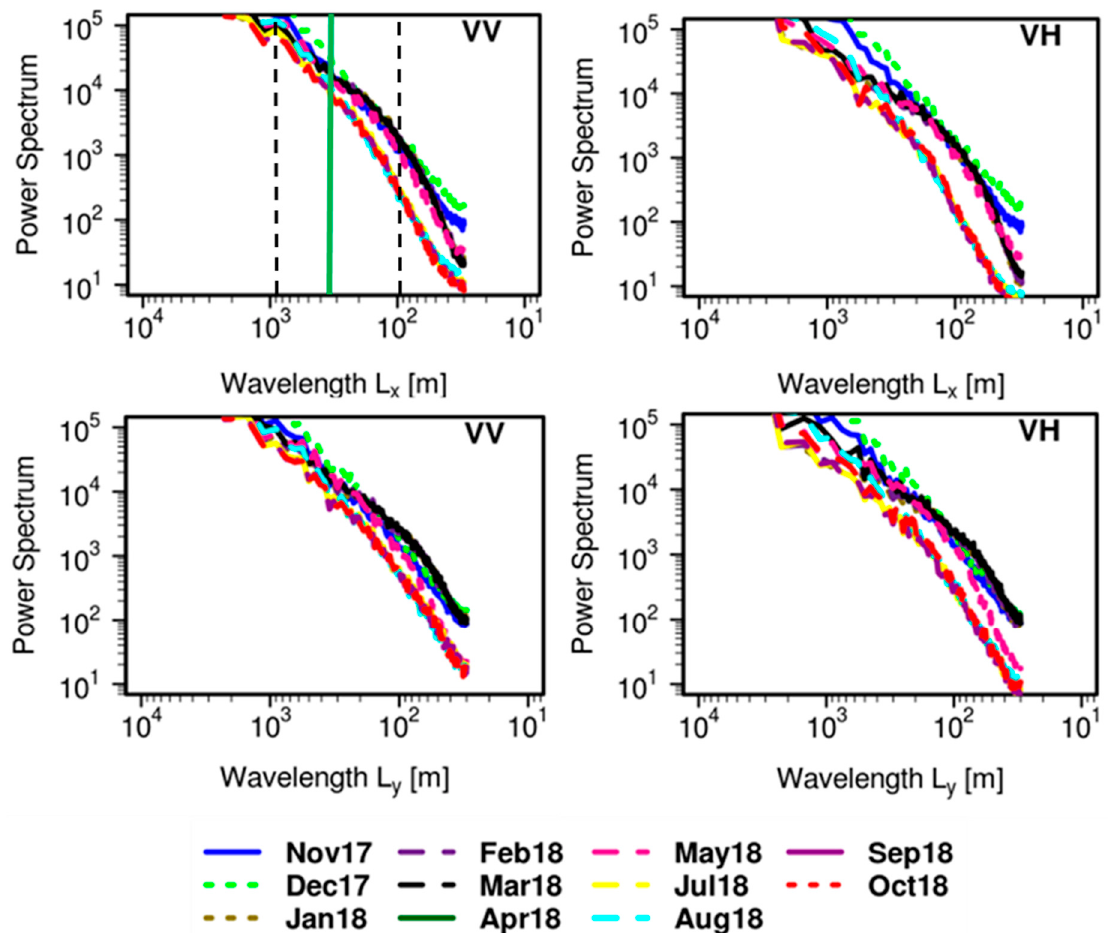
Figure 16. BSC power spectra for the Swiss Alps during 2018 in the x- (top row) and y- (bottom row) directions. The black vertical lines in the top-left panel mark the range of scales used to calculate the slope (Table S3); the green vertical line marks the scaling break.